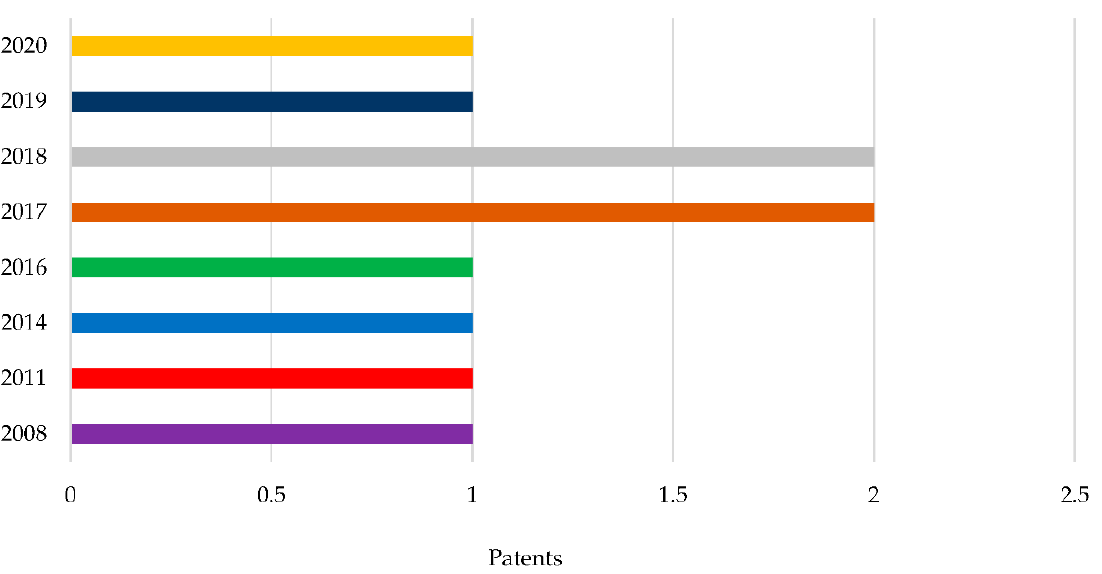
Figure 5. Distribution of patent publications related to Platonia insignis.